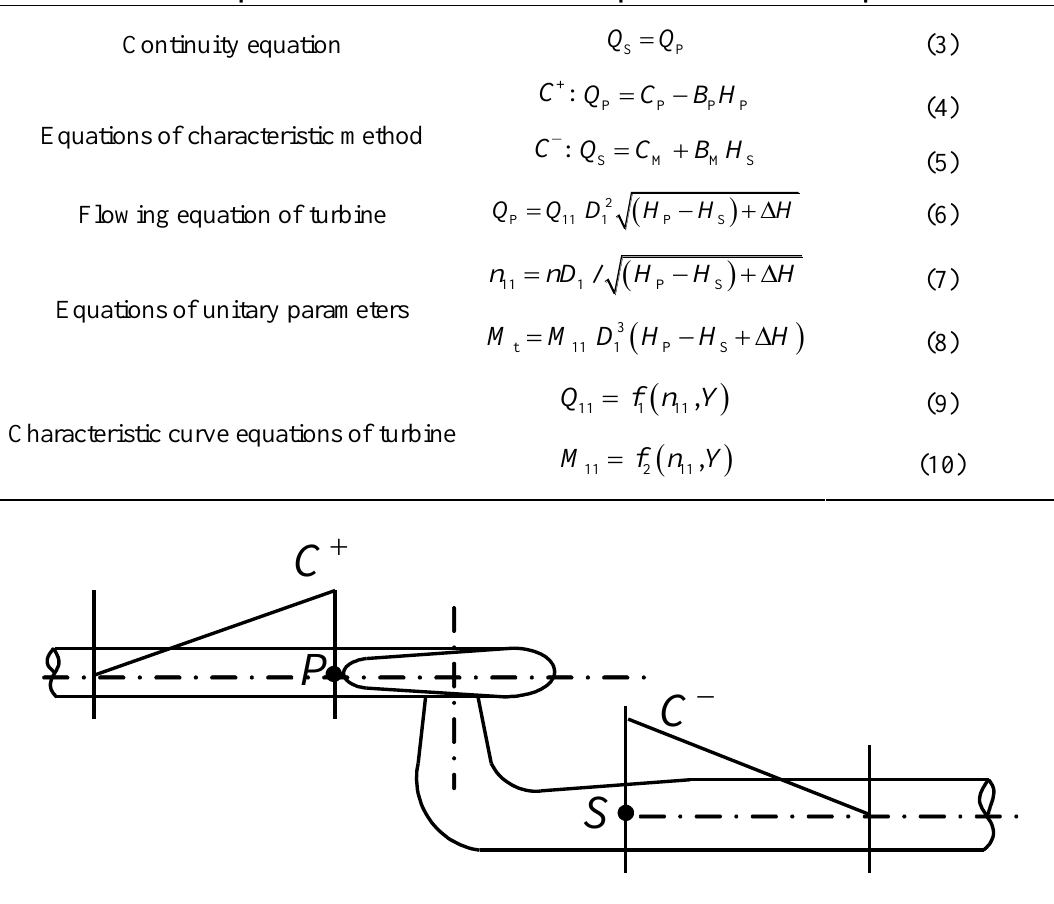
Figure 2. Illustration of the reaction turbine